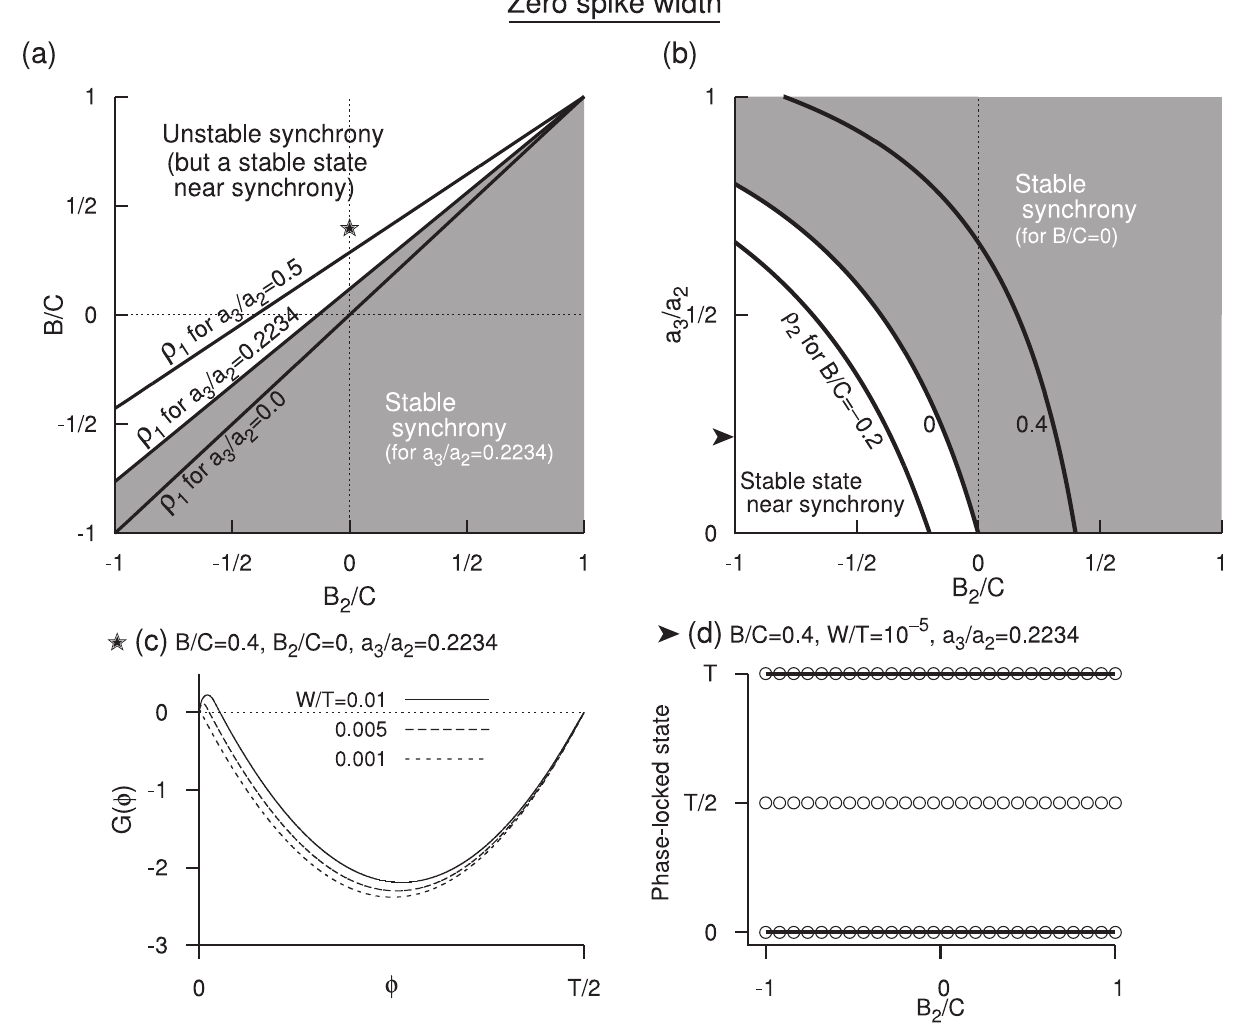
Figure 3. Edge effects when spike width is zero. (a) Stable synchrony (shaded region) and the unstable synchrony (white region) for a 3 = a 2 ~ 0 : 2234 in the plane of B 2 = C and B = C . Boundary curves for two other levels of a 3 = a 2 are also shown. (b) Same as in (a) but in the plane of B 2 = C and a 3 = a 2 for B = C ~ 0 . Boundary curves for two other level of B = C are also displayed. These curves are obtained by inverting equation r 1 for a 3 = a 2 . Antisynchrony is unstable in the displayed parameter ranges in (a) and (b). (c) Growth function G ( w ) , in the limit of zero spike width, displaying unstable synchrony but a stable phase-locked state that is very close to the synchronous state for a parameter value that is in the unstable synchrony region. (d) One-parameter bifurcation diagram as a function of B 2 = C .